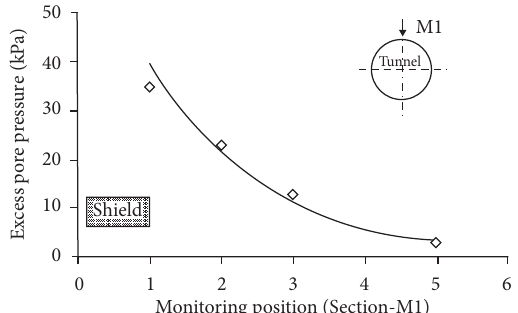
Figure 6: Distribution of excess pore water pressure in the lon- gitudinal